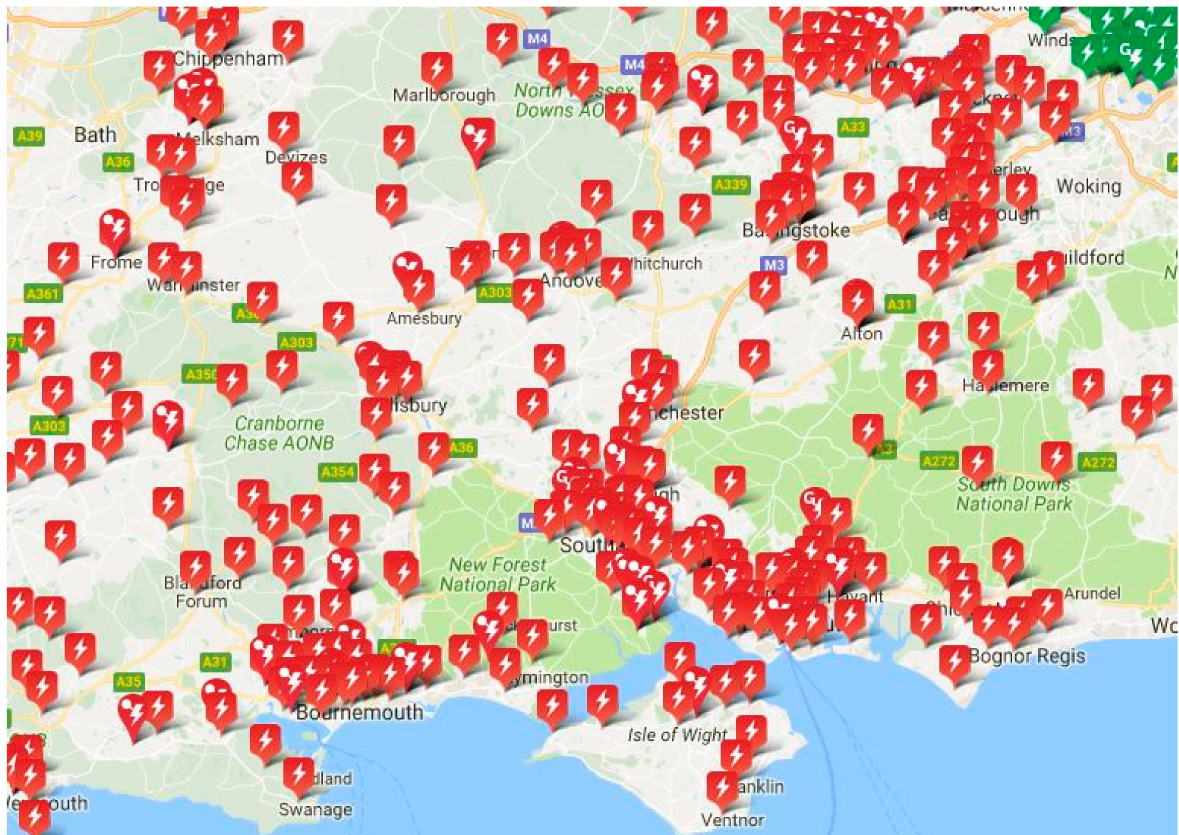
Figure 9. Google map of substations with restrictions (red) and without restrictions (green) on the injection of renewable energy in Southampton, United Kingdom